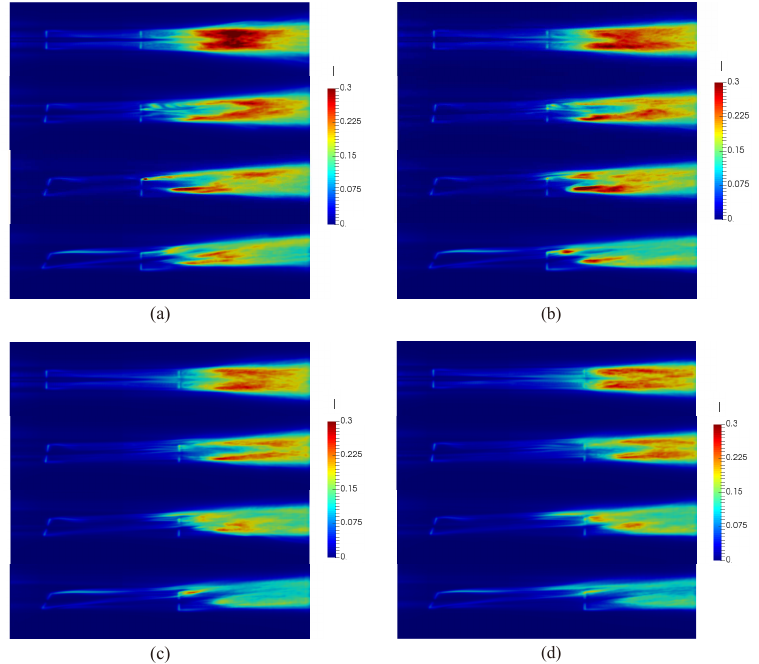
Figure 14. Contours of instantaneous turbulence intensity in a horizontal plane at hub height: ( a ) spacing = 5D; ( b ) spacing = 6D. ( c ) spacing = 7D; ( d ) spacing = 8D.